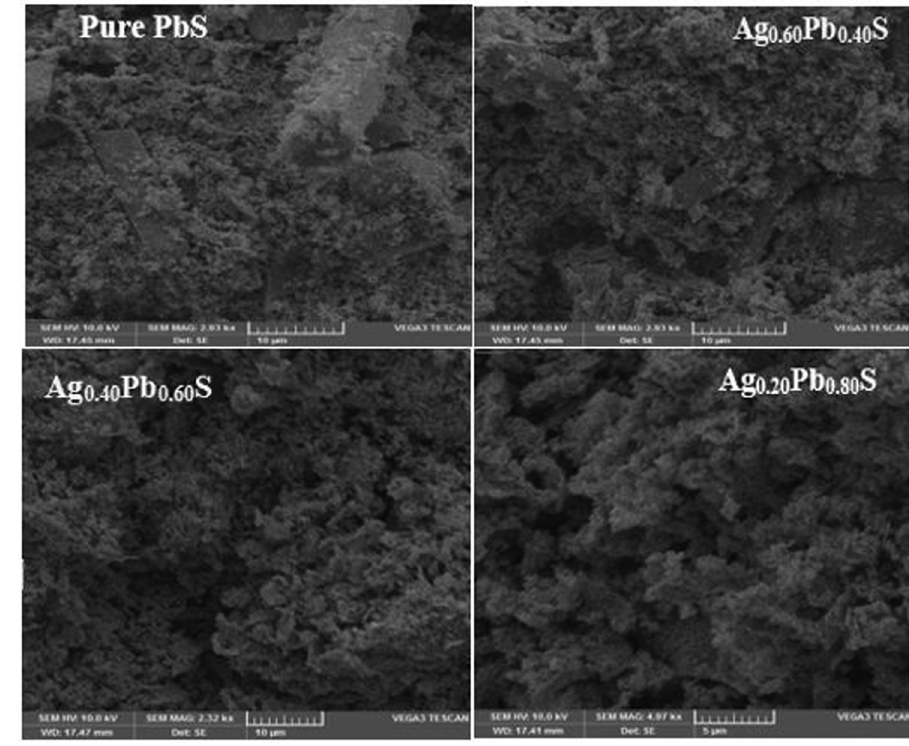
Figure 4: SEM micrographs of pure PbS and Ag:PbS at di ff erent concentrations: ( a ) 20%, ( b ) 40%, and ( c )